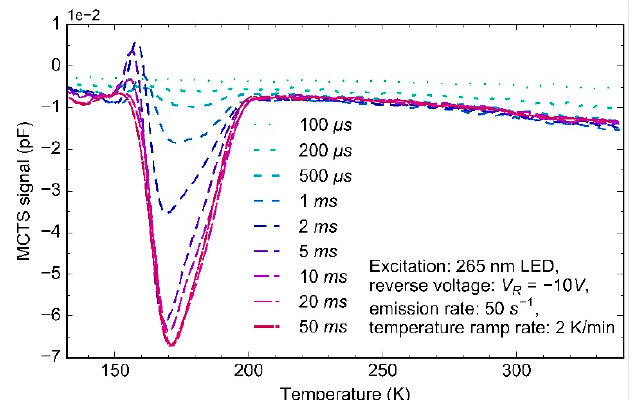
Figure 6. The MCTS spectra for different optical pulse widths (emission rate 50 s − 1 ). The optical excitation was carried out with 265 nm LED light. The SBD was kept at the constant reverse bias V R = − 10 V. The optical pulse widths are shown in the legend.